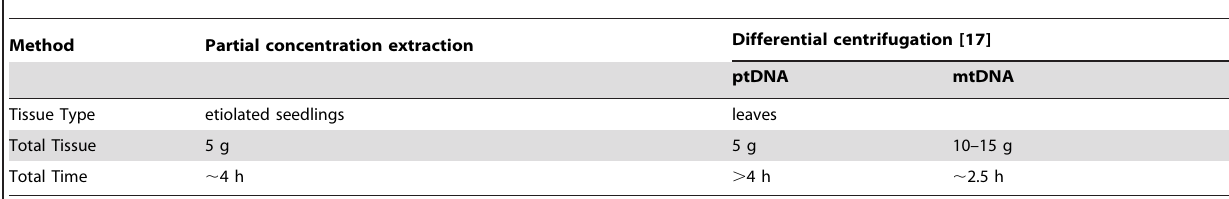
Table 2. Comparison between partial concentration extraction and differential centrifugation.